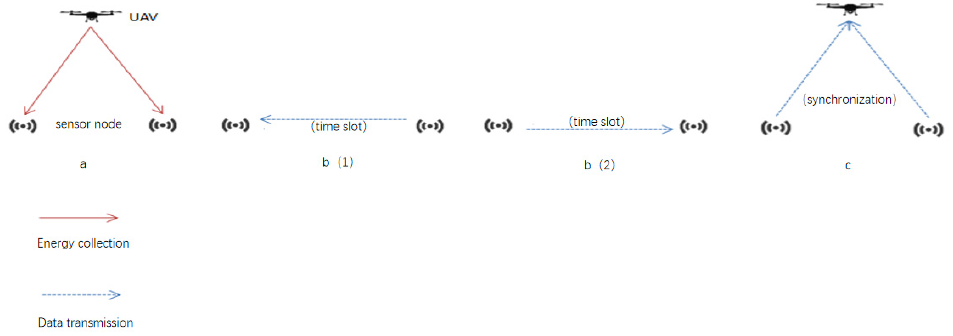
Figure 2. Three steps of energy charging and data transmission. ( a ) energy charging ( b1 , b2 ) local cooperation ( c ) cooperative transmission